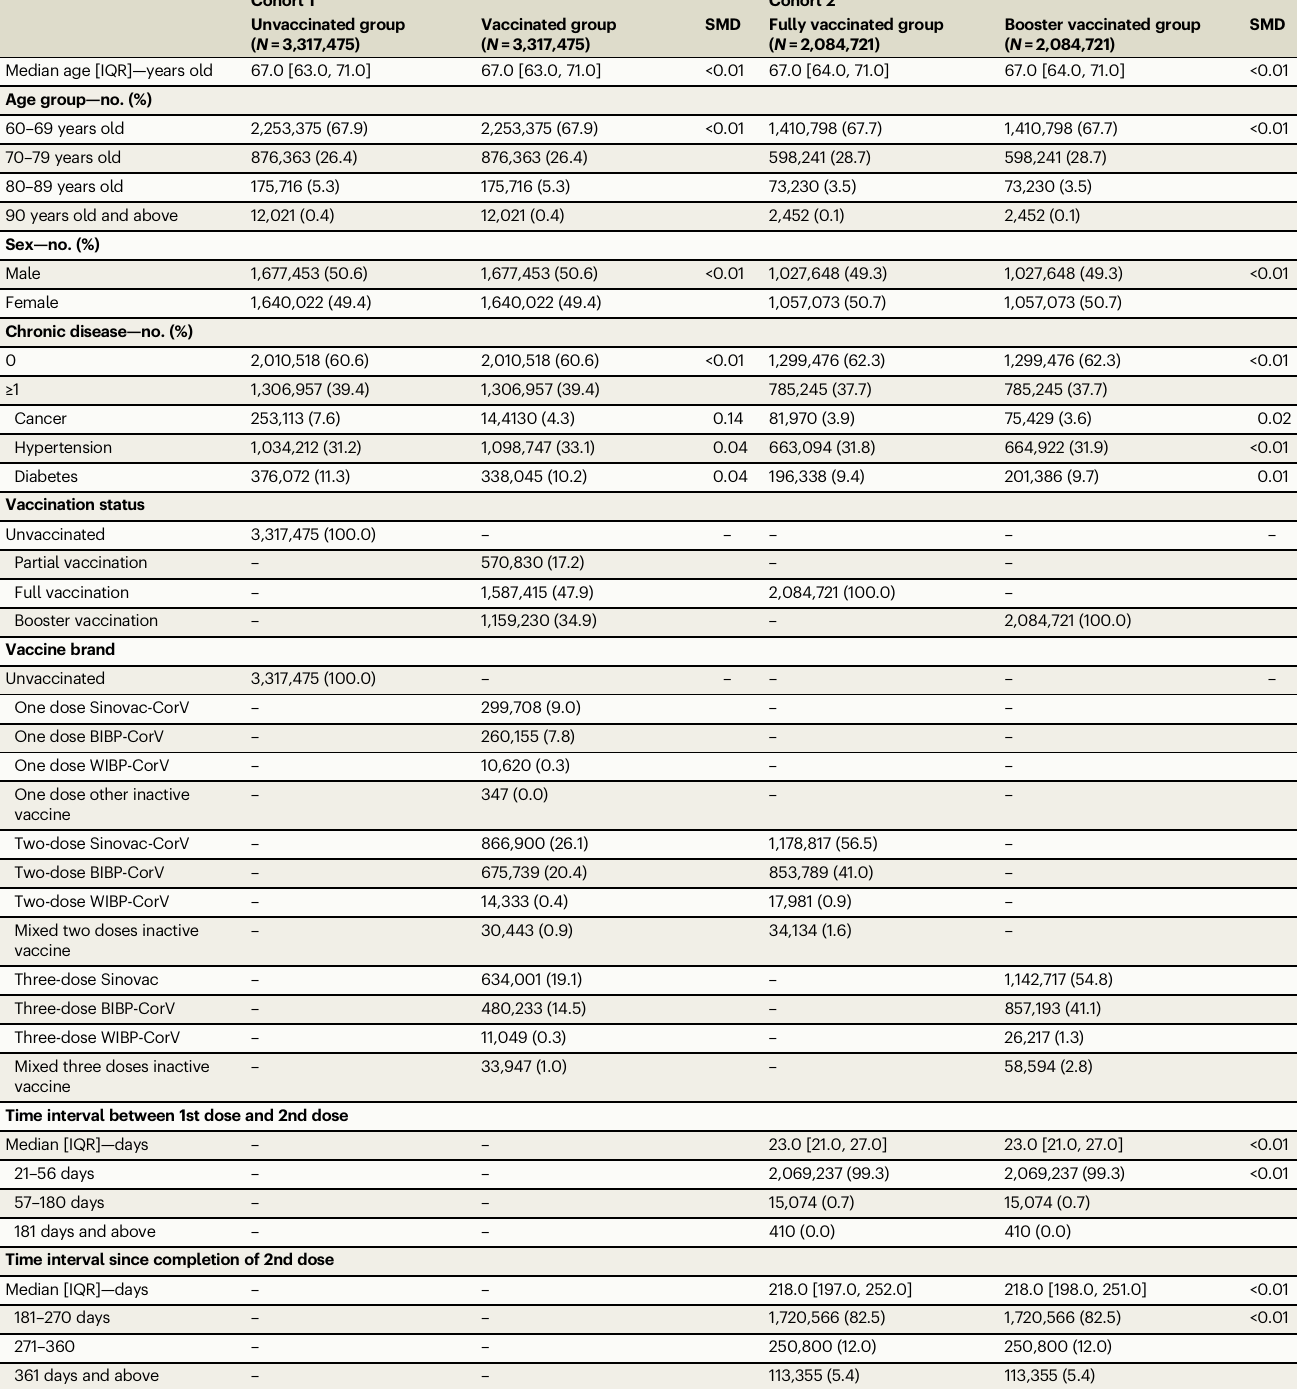
Table 1 | Baseline demographic characteristics of cohort 1 and cohort